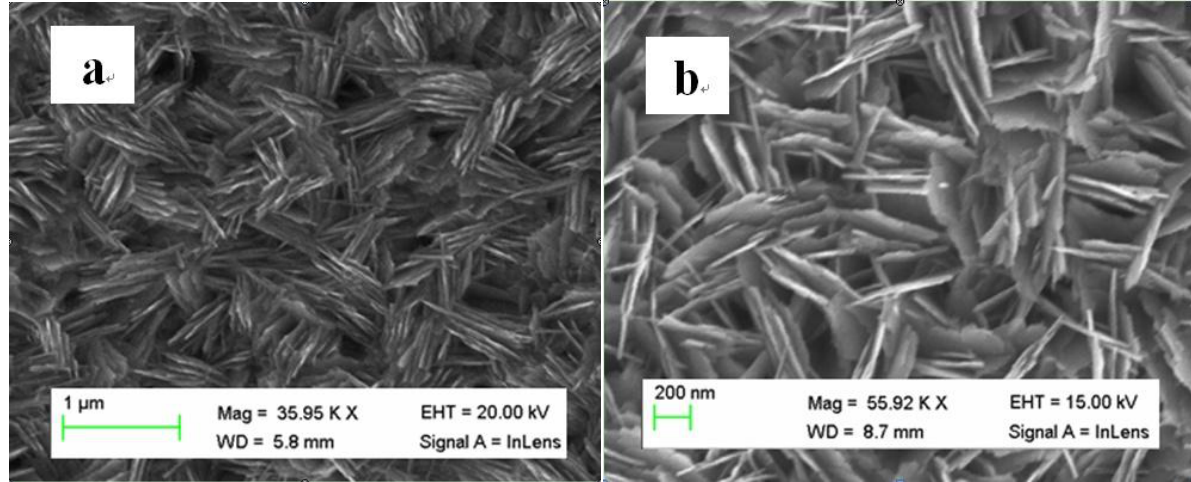
Figure 2. The SEM image of CuO nanosheets ( a ) low magnification image; and ( b ) high magnification